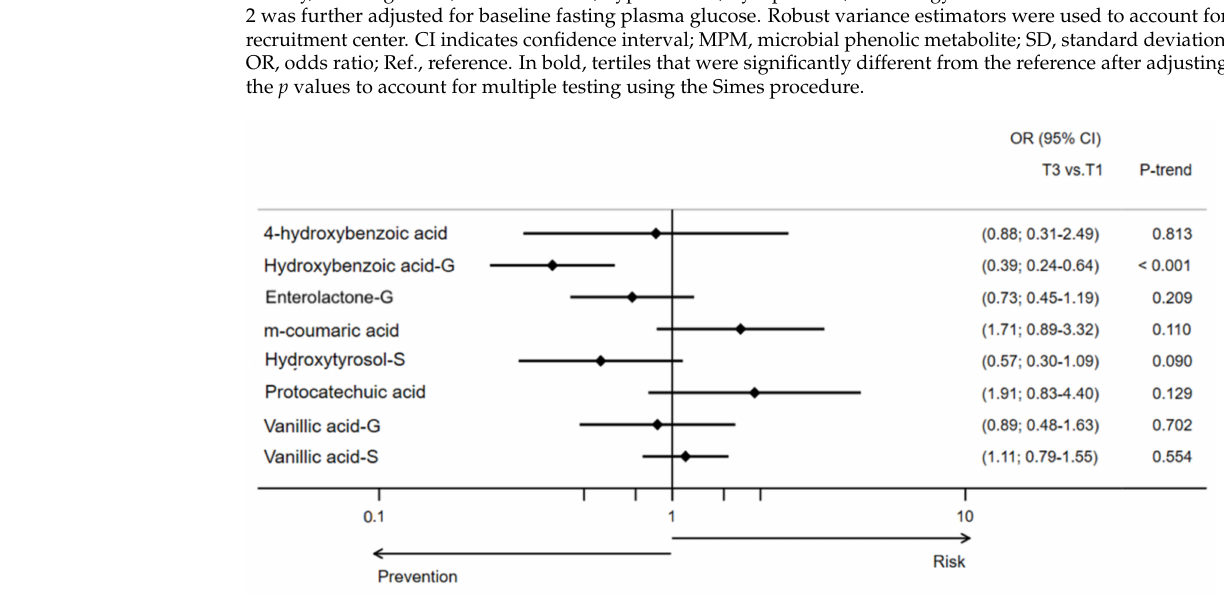
Figure 2. Likelihood (OR [95% CI]) of type 2 diabetes development by one-year changes in urinary concentrations of MPM in the PREDIMED Study. This model was adjusted for sex, age, inter- vention group, body mass index, physical activity, smoking status, education level, hypertension, dyslipidemia, and energy